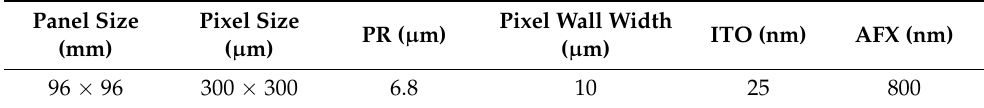
Table 1. Fabrication parameters of full-color EWD.